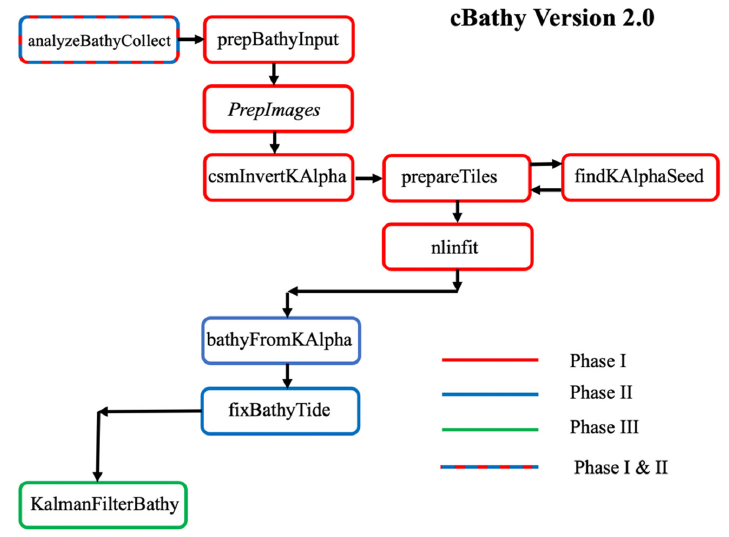
Figure 6. New organization of cBathy version 2.0 with the partitioning into tiles happening later. “PrepImages” is added to create timex and other image types from the time stack and is not integral to the cBathy calculations.